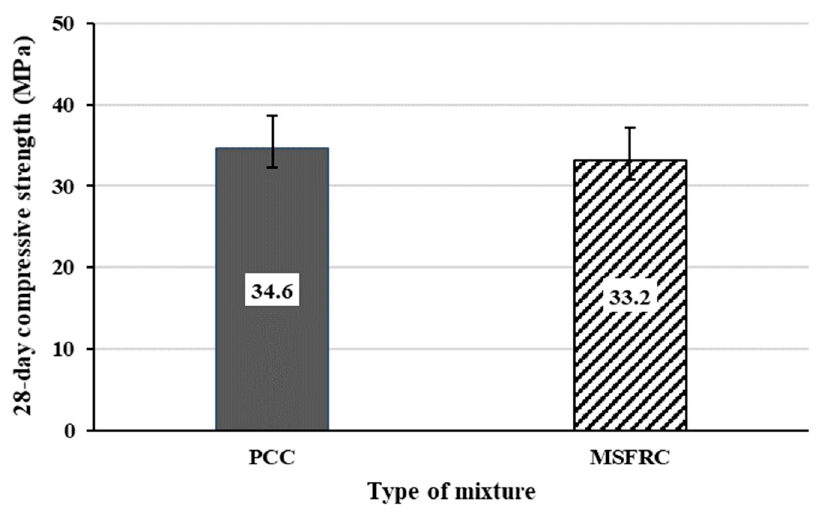
Figure 6. Compressive strength test results.